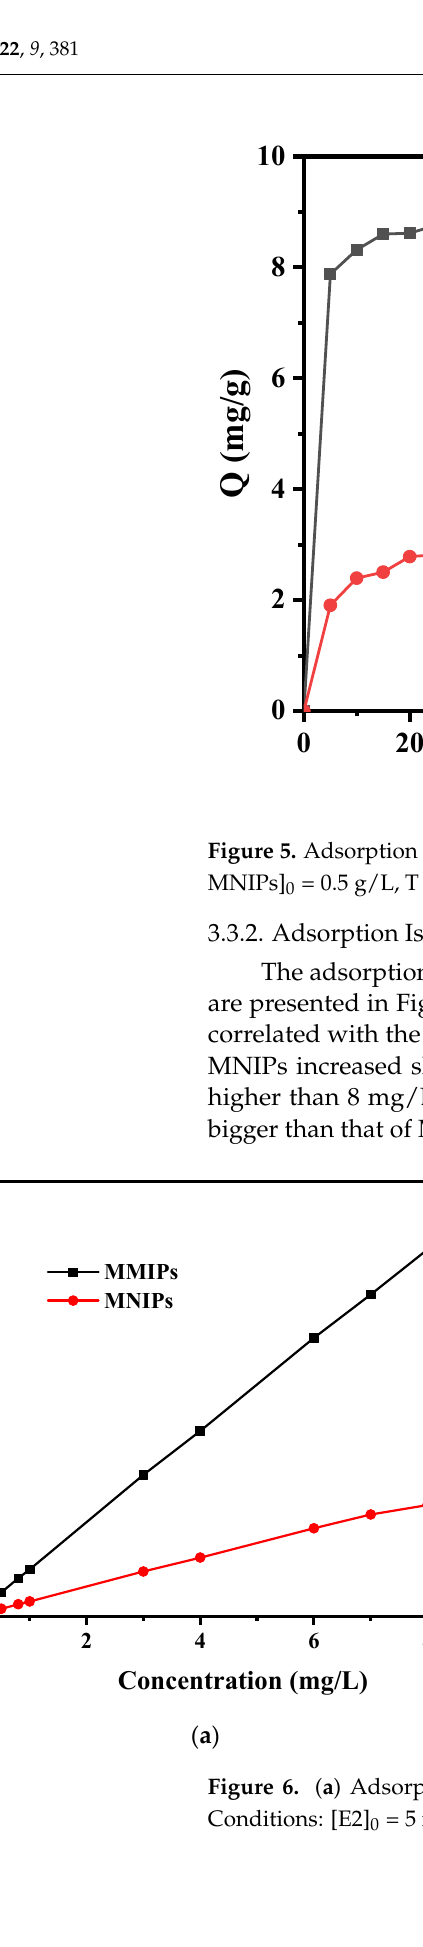
7 of 15 Figure 4. Nitrogen adsorption–desorption isotherm of MMIPs. 3.3. Adsorption Performance 3.3.1. Adsorption Kinetics The adsorption kinetics curves of E2 by MMIPs and MNIPs were investigated in this study. From Figure 5, the adsorption rates of MMIPs and MNIPs were fast in the first 5